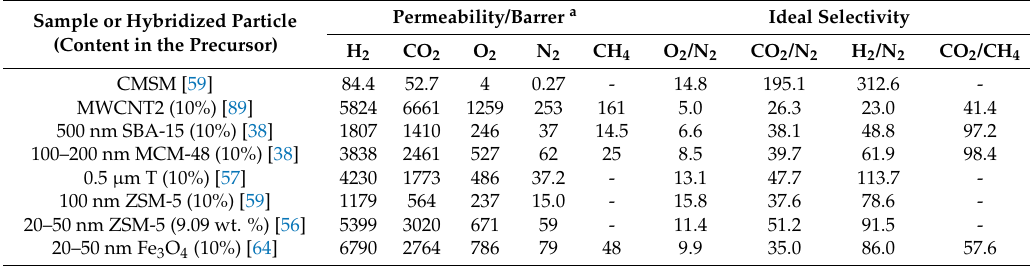
Table 11. Gas permeability and selectivity of pure CMS membrane and representative hybrid CMS